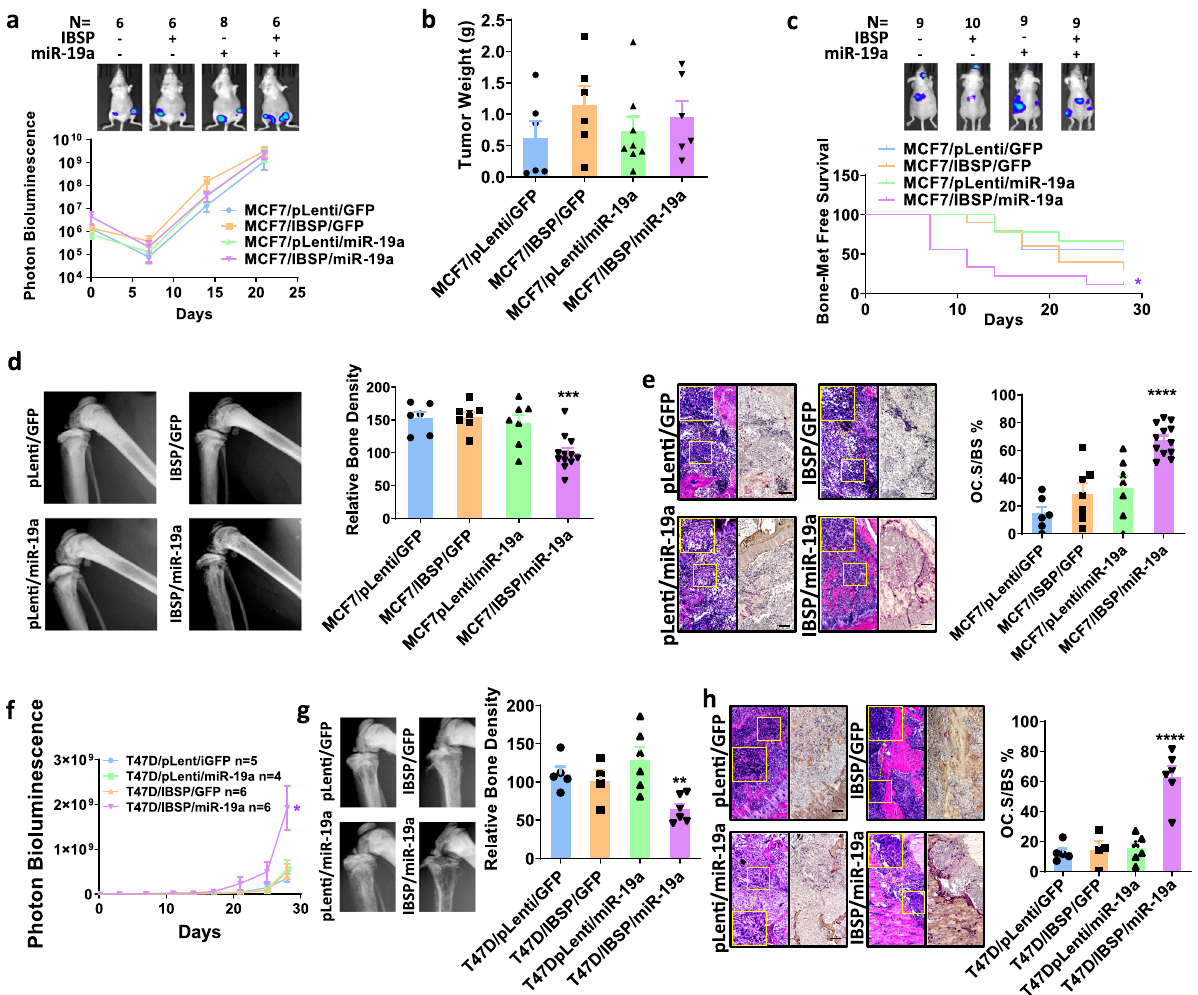
Fig. 2 Both IBSP and miR-19a are essential for bone metastasis of ER + breast cancer. a miR-19a and/or IBSP were ectopically expressed in MCF7, and they were transplanted into mammary fat pads of female nude mice. The growth of the tumor was monitored by measuring the luciferase activity by IVIS Bioimager. p = 0.3110 (MCF7/pLenti/GFP vs MCF7/IBSP/miR-19a; n = 6 vs 6), p = 0.2649 (MCF7/pLenti/GFP vs MCF7/IBSP/GFP; n = 6 vs 6), p = 0.4739 (MCF7/pLenti/GFP vs MCF7/pLenti/miR-19a; n = 6 vs 8). Data are presented as mean values ± SEM. b At day 21, tumors were removed from the mammary fat pad and their weights were measured. p = 0.3971 (MCF7/pLenti/GFP vs MCF7/IBSP/miR-19a; n = 6 vs 6), p = 0.2178 (MCF7/pLenti/ GFP vs MCF7/IBSP/GFP; n = 6 vs 6), p = 0.7632 (MCF7/pLenti/GFP vs MCF7/pLenti/miR-19a; n = 6 vs 8). Data are presented as mean values ± SEM. c